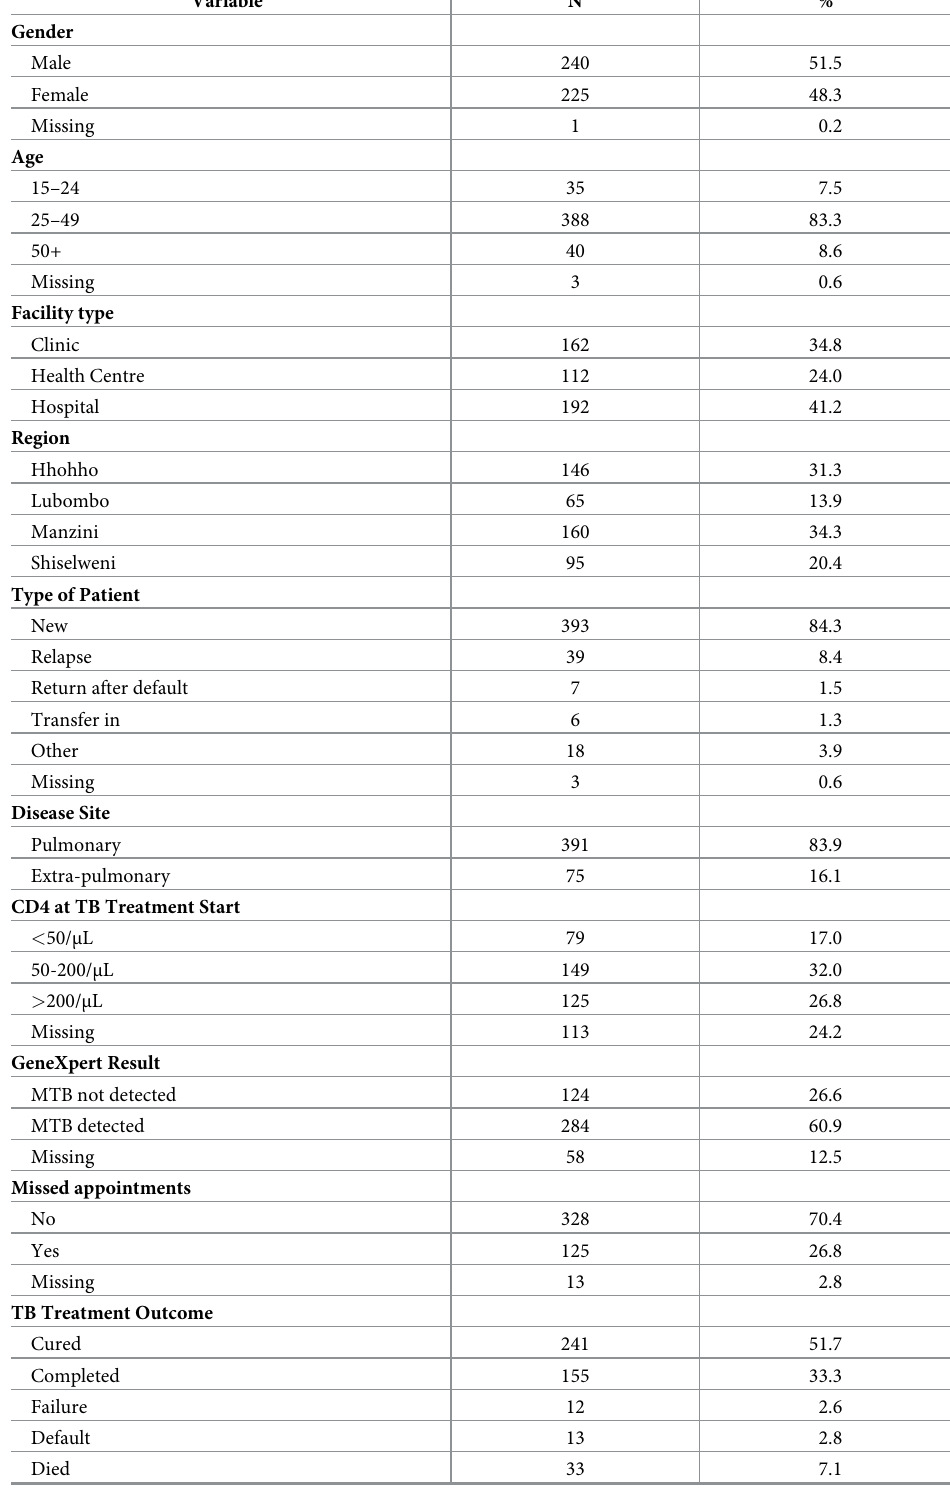
Table 1. Demographic and clinical characteristics of HIV-positive TB patients (N =